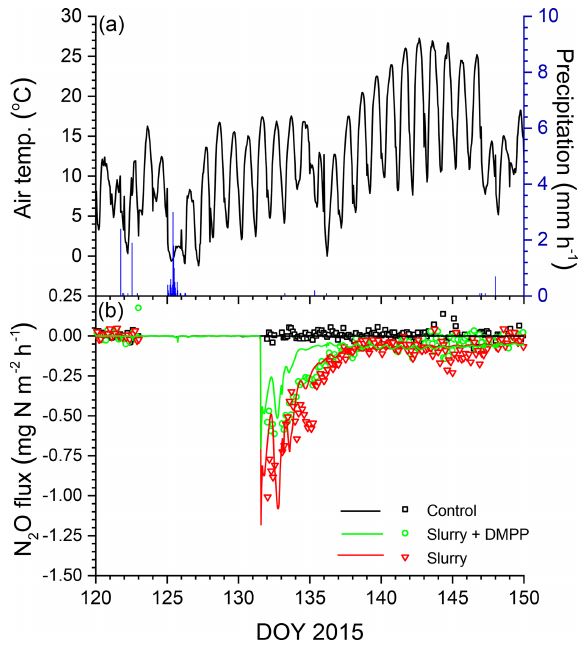
Figure 6. (a) Air temperature and precipitation and (b) N 2 O fluxes measured (symbols) and modelled (lines) during spring 2015 with no slurry (control) and following slurry application on DOY 132 in 2015 with or without DMPP. Negative values denote emissions.